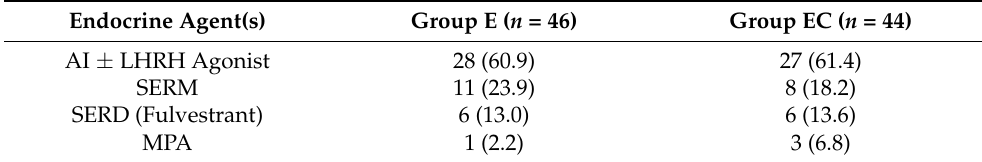
Table 2. Endocrine agents used as maintenance therapy.